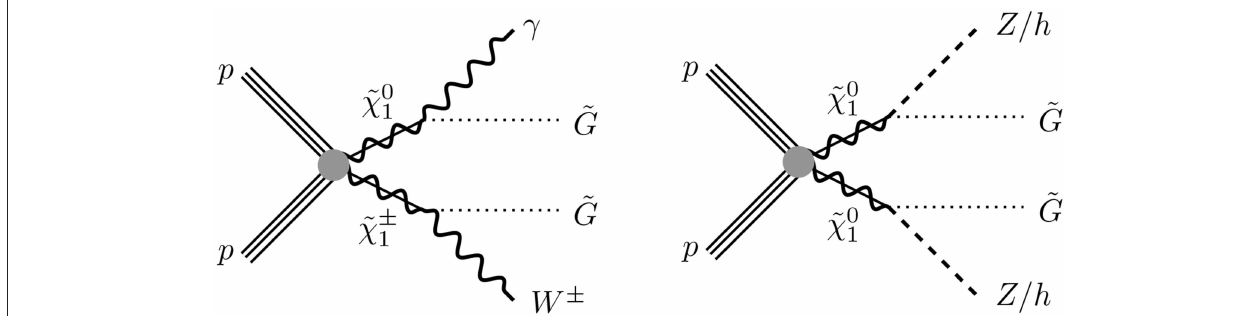
FIGURE 11 | Topologies for SUSY searches with gravitino LSP and γ and h / Z final states.